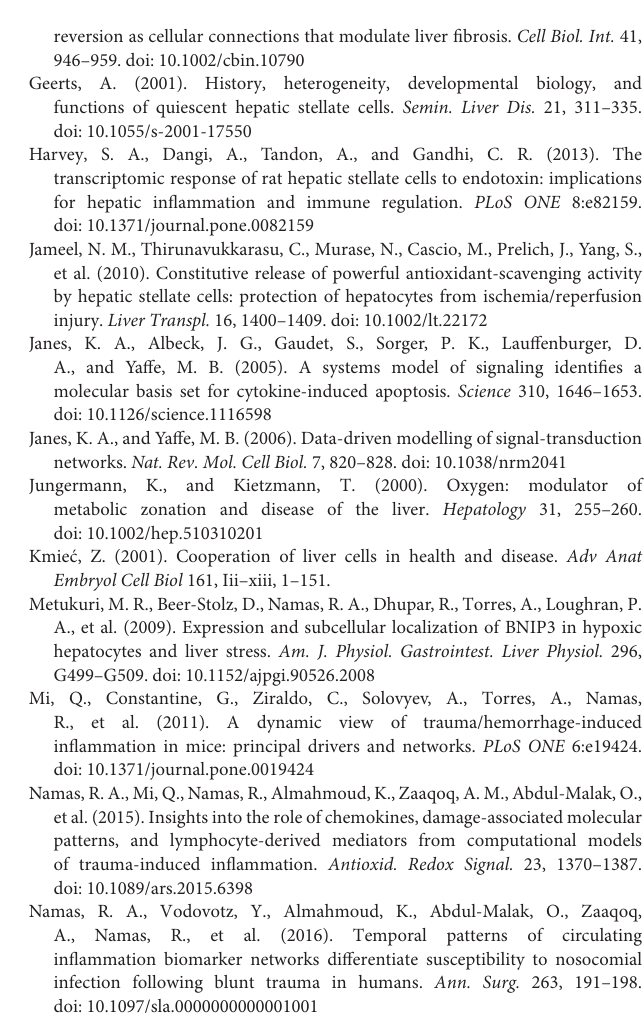
Supplementary Figure 3 | Network Analysis of inflammatory mediators in mouse hepatic stellate cells (HSC) and hepatocytes (HC). Freshly isolated HSC and HC from C57BL/6 mice were cultured under 21% O 2 for 24h (control) or hypoxia (6h) followed by reoxygenation for 18h (as in Supplementary Table 1 ). Inflammatory mediators released into cell culture media (CCM) and in whole cell lysate (WCL) were measured by Luminex TM and Network Analysis was performed as described in Materials and Methods . Figure shows the networks (stringency level 0.95) for each experimental condition in both cell types in CCM (A) and WCL (B) . Black and red arrows represent positive and negative connections, respectively. Supplementary Table 1 | Network Analysis of inflammatory mediators using the combined data of both the cell culture media (CCM) and whole cell lysate (WCL) in mouse hepatic stellate cells (HSC) and hepatocytes (HC). Freshly isolated HSC and HC from C57BL/6 mice were cultured under 21% O 2 for 6h (control), hypoxia (1% O 2 ) for 6h or hypoxia (6h) followed by reoxygenation for 18h. Inflammatory mediators released into cell culture media (CCM) and in whole cell lysate (WCL) were measured by Luminex ® and Network Analysis was performed as described in Materials and Methods . The figure shows the detailed connectivity (stringency level 0.95) for each experimental condition combining the data in CCM and